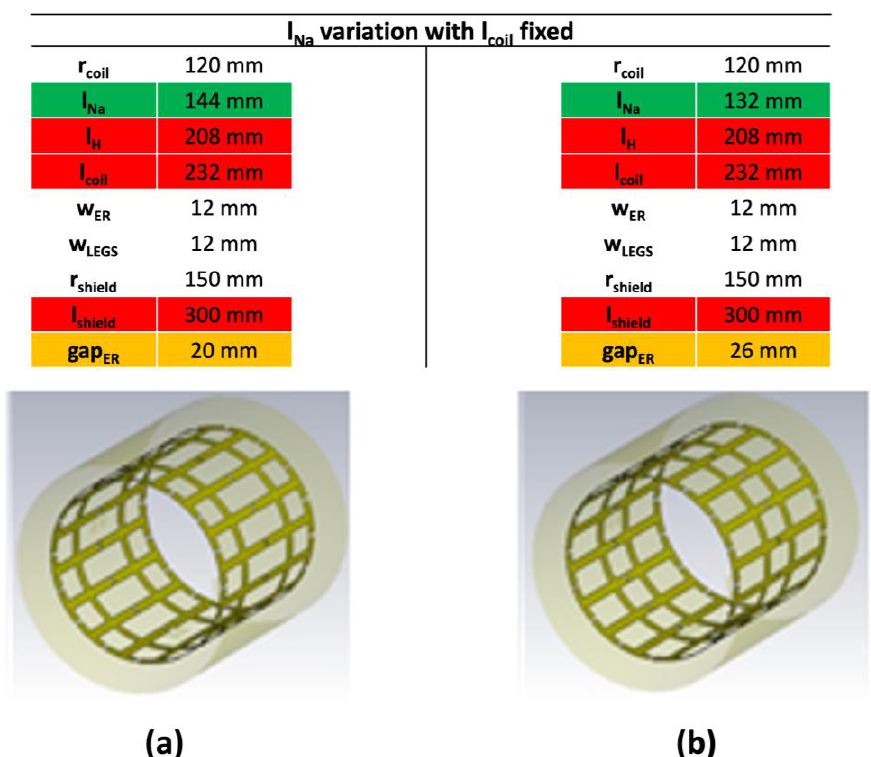
Figure 5 . EM CAD model of the four-ring DT-RF coil model versus the geometrical dimensions. The l Na variable parameter is in green, while the parameters changing with the l Na parameter are in orange (gap ER ). In red are the fixed parameters (l H , l coil , l shield ). Then, a cylindrical phantom model was included in the simulation models (Figure 6).